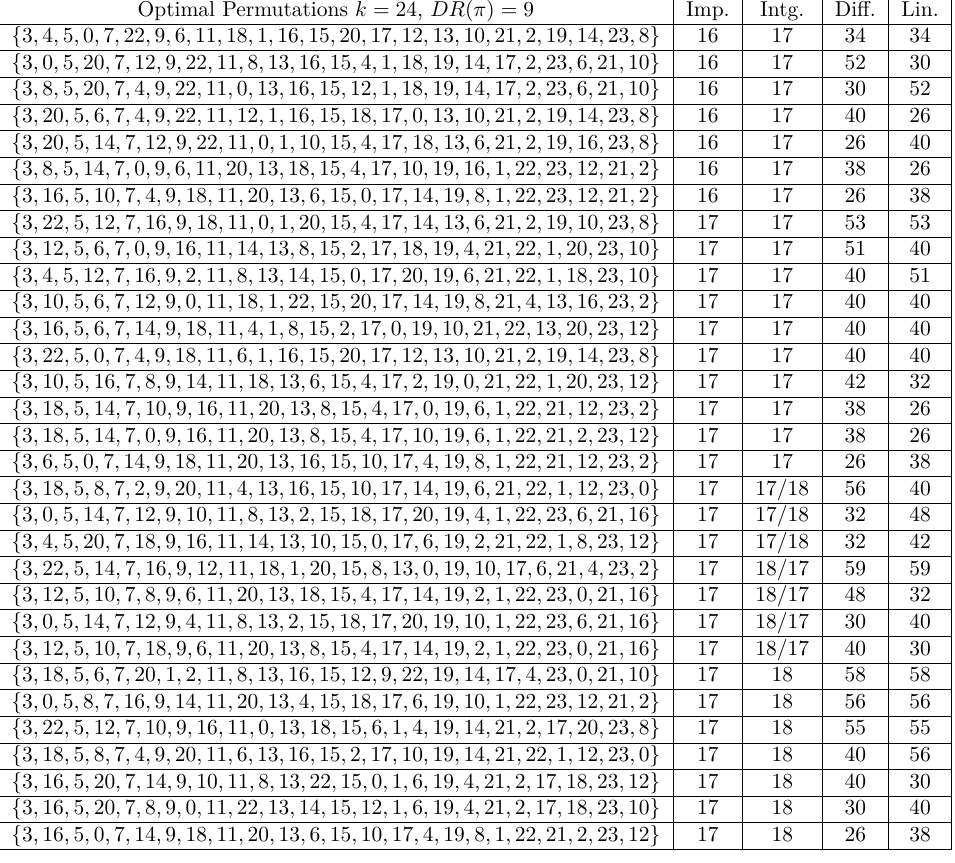
Table 20: Optimal even-odd permutations for k = 24 up to extended pair-equivalence Optimal Permutations k = 24, DR ( π ) = 9 Imp. Intg. Diff. Lin.